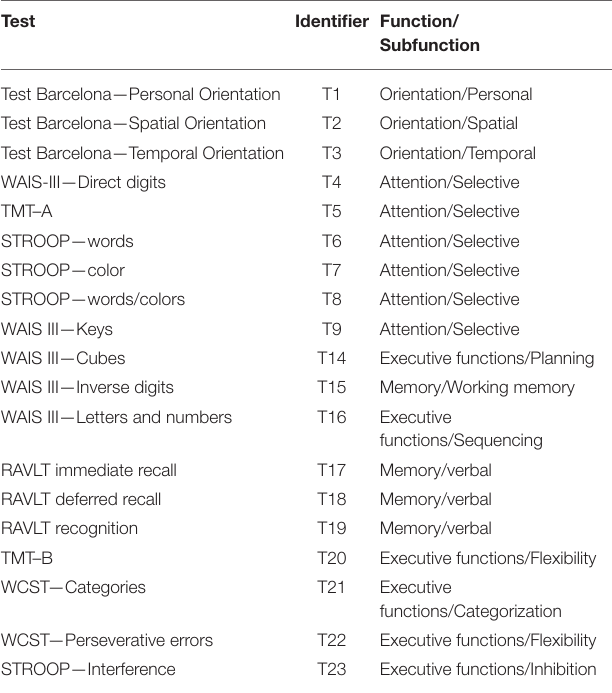
TABLE 1 | Neuropsychological assessments at admission with the identifiers used for each of them along this study.